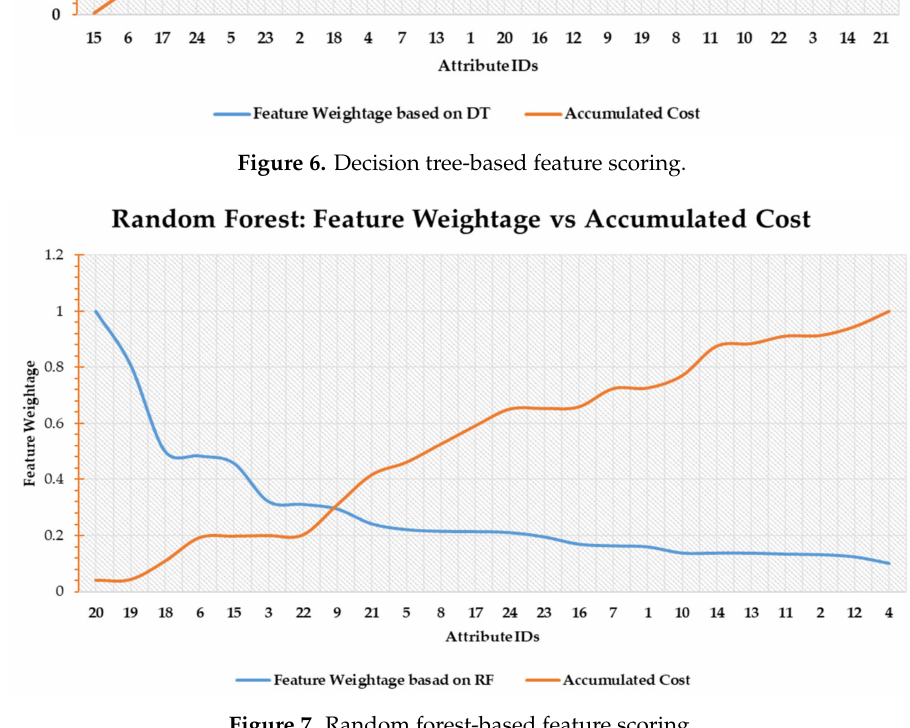
Figure 7. Random forest-based feature scoring.